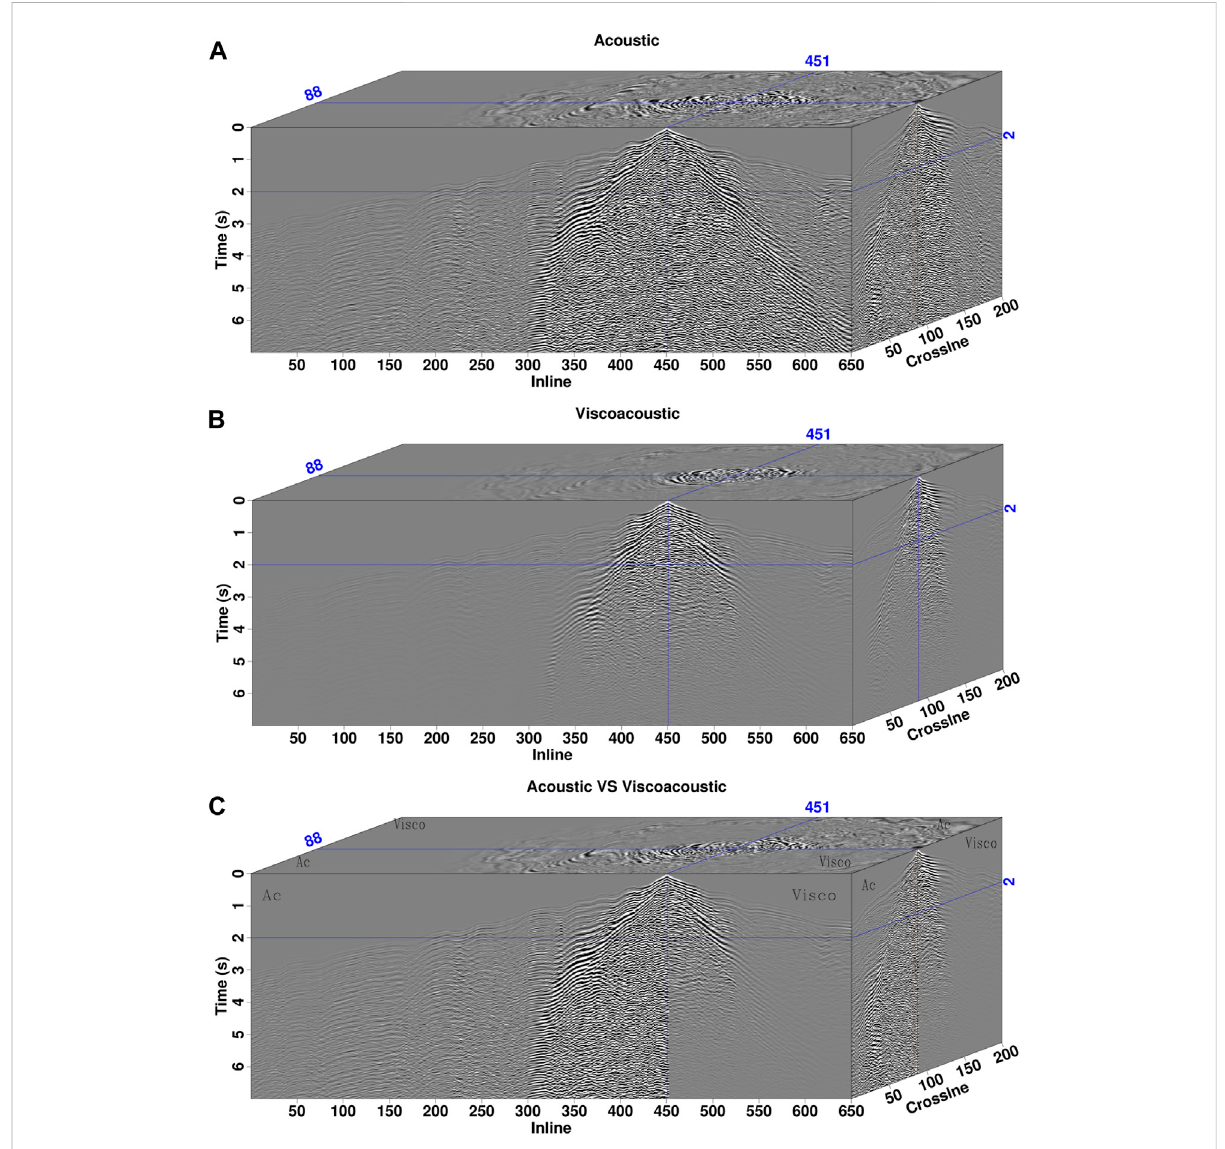
FIGURE 21 (A – C) Common-shot gathers of 3D Loess Plateau model with the source location at the valley. The panel notations are the same as those in Figure